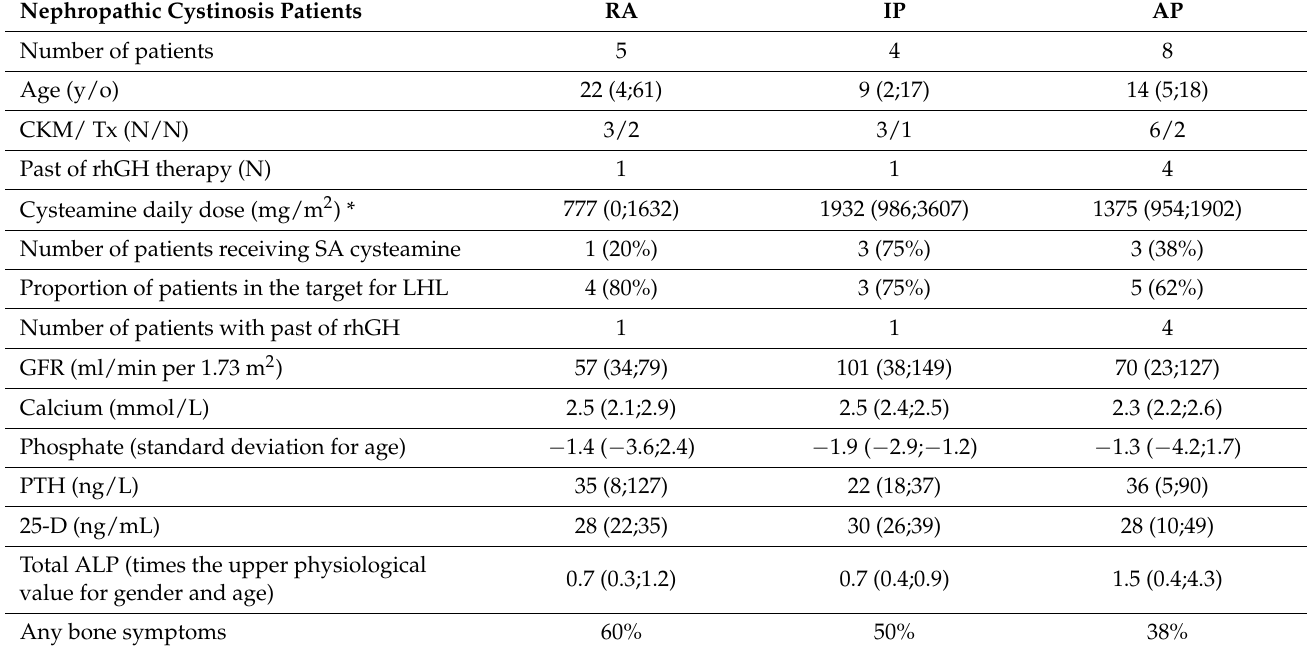
Table 6. Patients’ characteristics according to the underlying